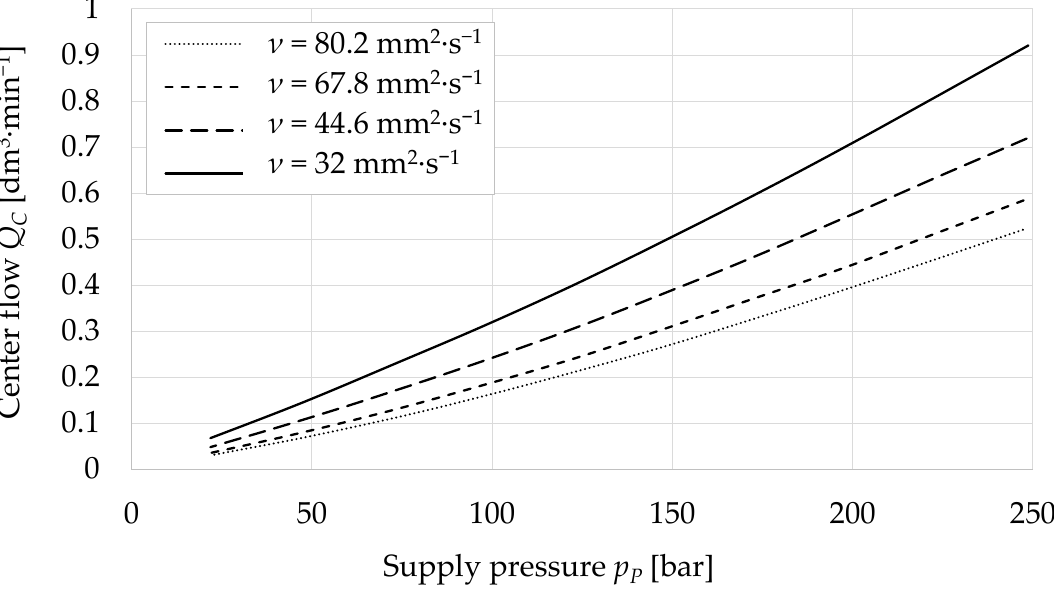
Figure 10. Center flow curves for different oil temperatures.